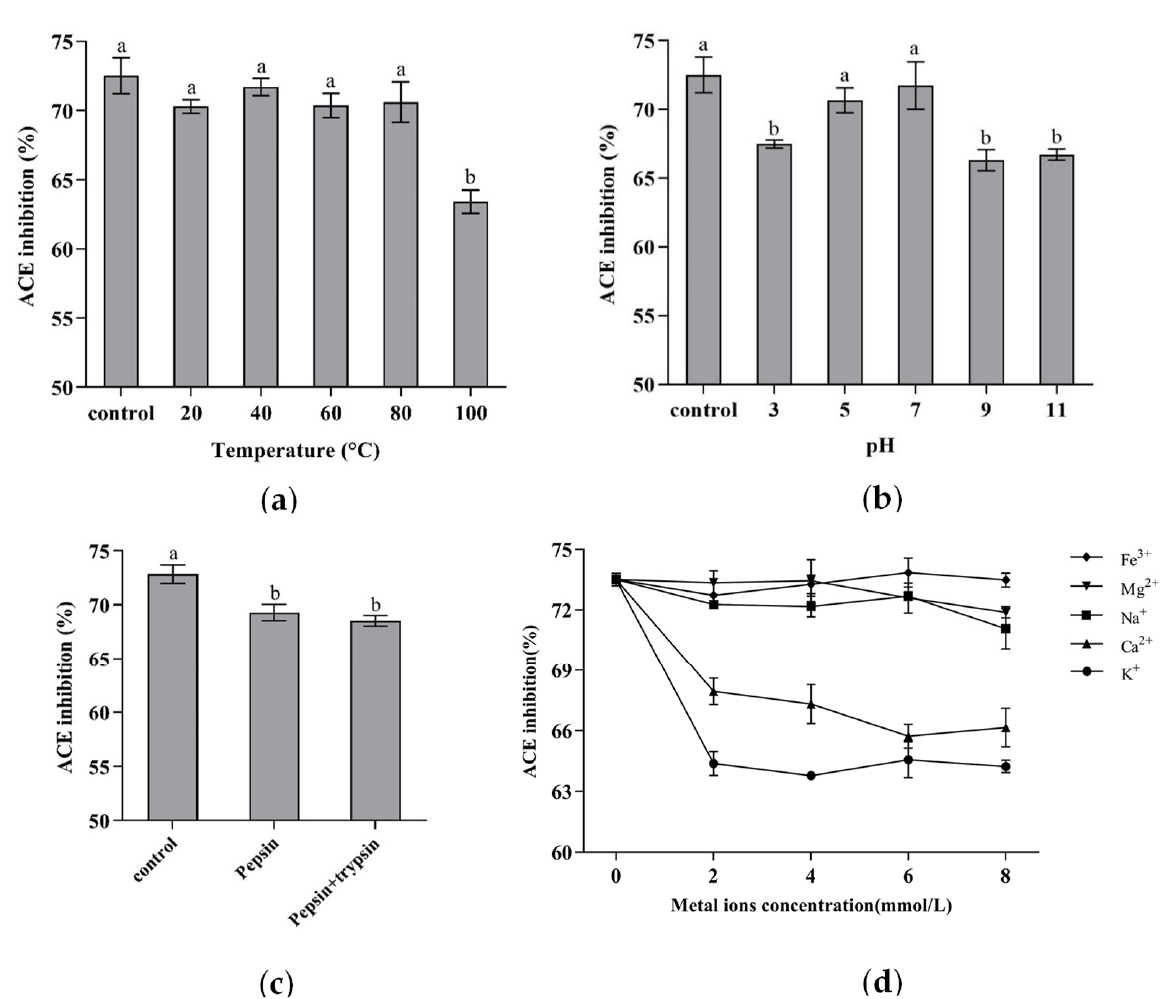
Figure 8. Stability of VVVPQN under heat treatment (a), different pH environments (b), gastrointestinal digestion (c), and addition of metal ions (d). The results are presented as the means ± SD (n = 3). Different letters indicate significant differences at p < 0.05.